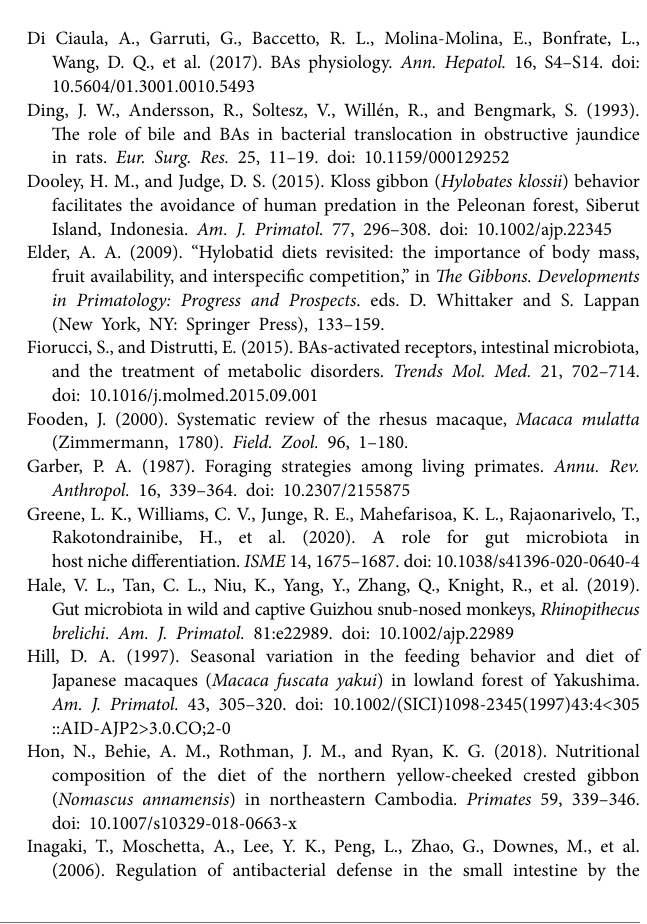
Supplementary Table S4 | Taxonomy annotation. Supplementary Table S5 | KEGG